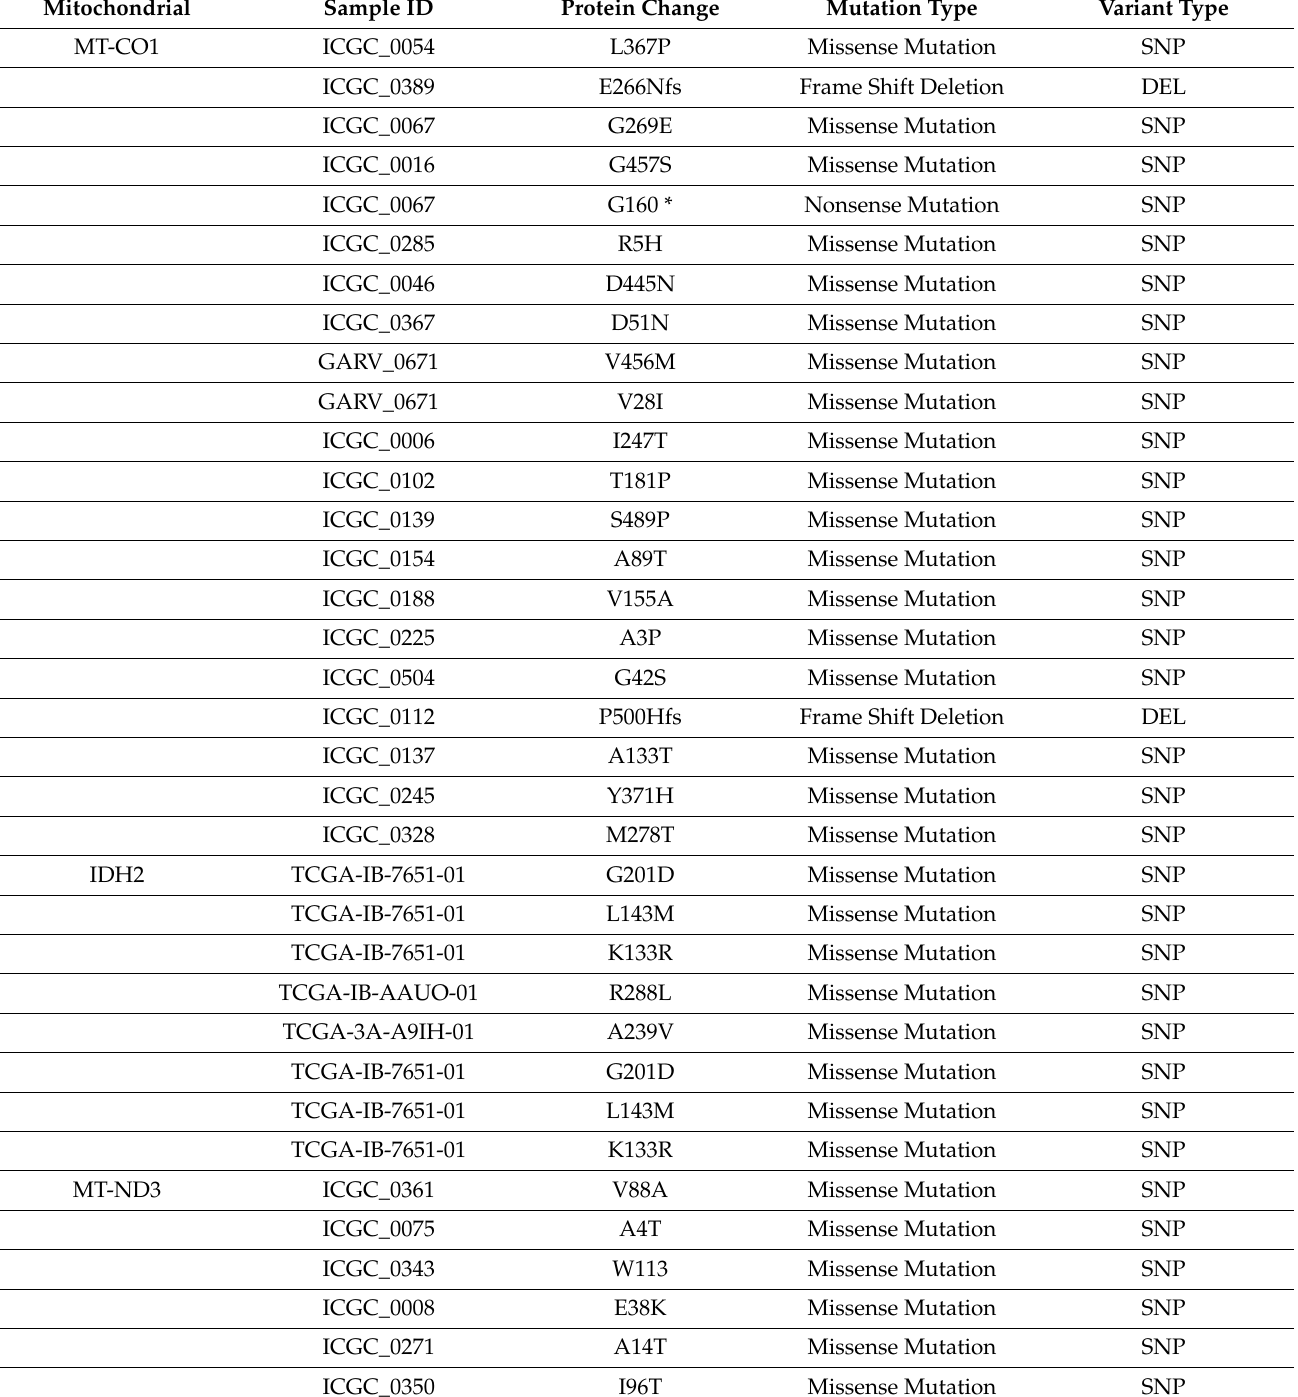
Table 1. Role of mitochondrial DNA in PDAC progression. (Data source: https://www.cbioportal. org/ accessed on 10 January 2023